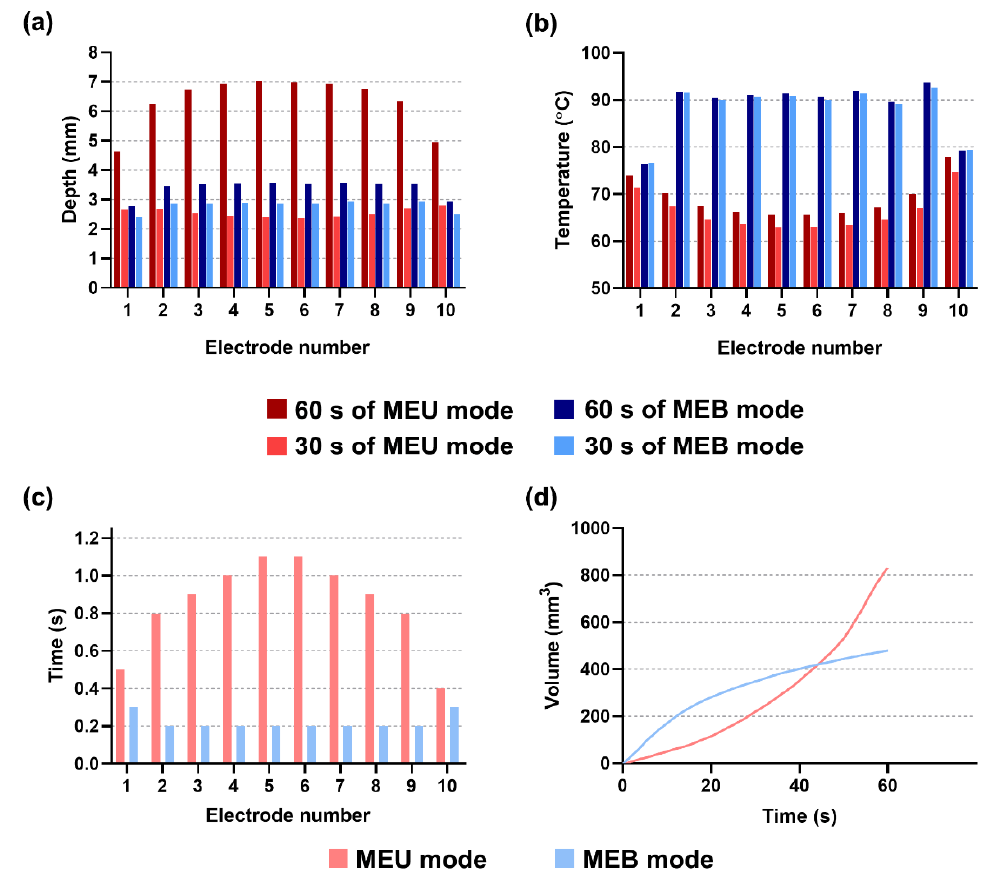
Figure 7. ( a ) Maximum depth of lesion and ( b ) Maximum temperature under each active electrode at 30 s and 60 s of RFCA. ( c ) Time required to generate effective lesion and ( d ) total lesion volume at 60 s of RFCA in MEU and MEB modes.